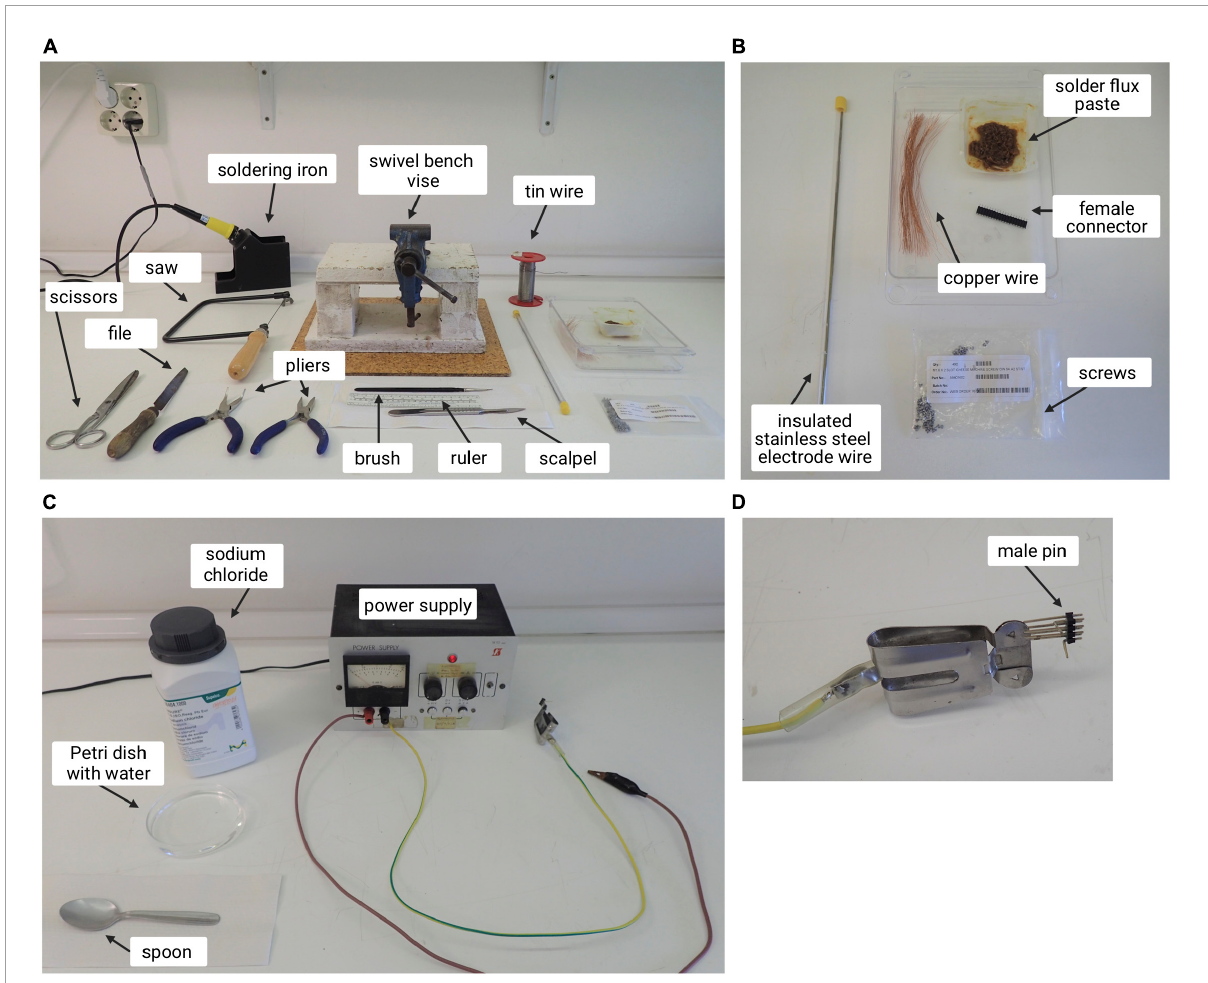
FIGURE1 Setup of the working area with instruments needed to build electrodes and ground screws. (A) Materials and tools used for the preparation of stimulation electrodes and ground screws. (B) Magnification of some of the materials needed for this process. (C) Power supply and materials used to check electrode current. (D) Male pin used to attach the electrode prepared to the power